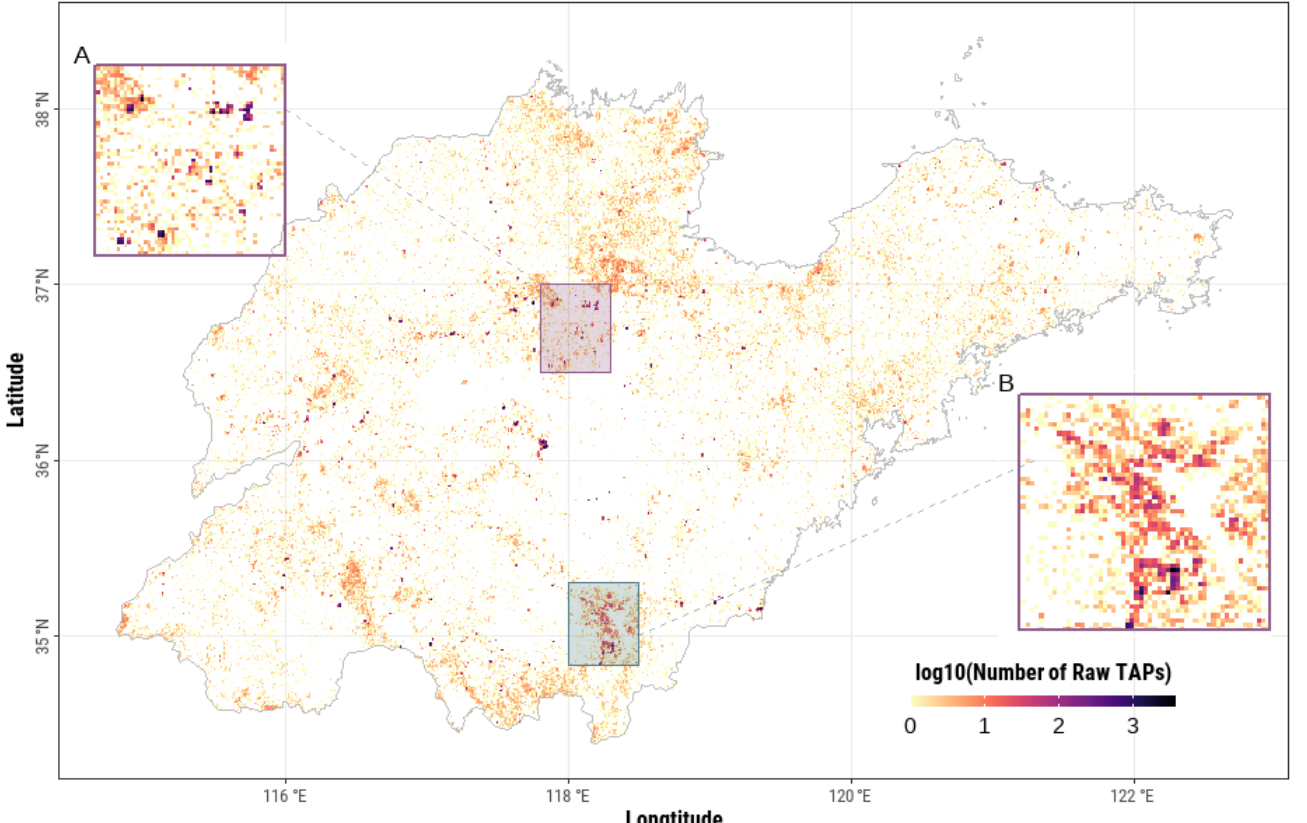
Figure 2. Spatial distribution of raw thermally anomalous pixels (TAPs) in Shandong Province. The total number of TAPs that fell in each 1 × 1 km pixel was logarithmically transformed to improve the visual effect. Two snapshots represent the TAP distribution in Zibo ( A ) and Linyi ( B ) cities, which feature the petrochemical industry and manufacturing industry, respectively.